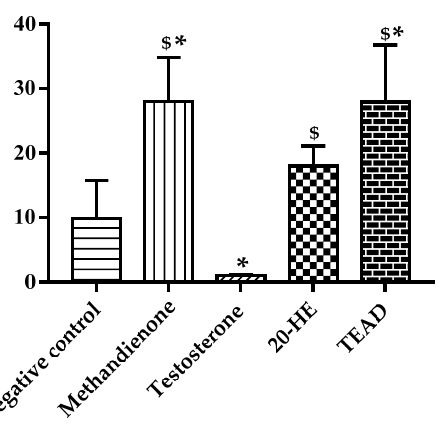
Figure 10. Average muscle bundle mass to secondary sex organs ratio. *: Significantly different from the negative control group at p < 0.001. $ : Significantly different from the testosterone group at p = 0.0011.